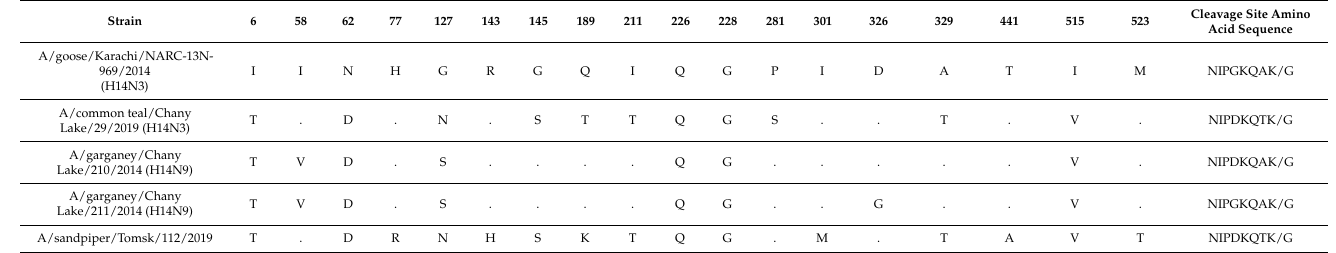
Table 6. Amino acid substitutions of hemagglutinin protein of H14-subtype AIVs.